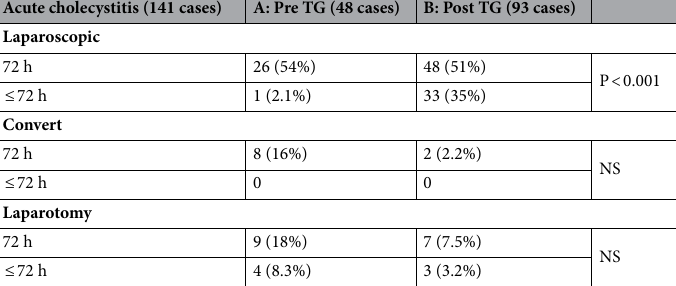
Acute cholecystitis (141